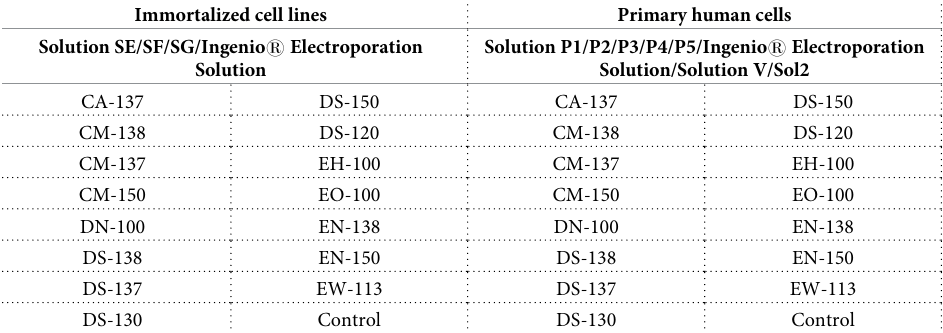
Table 1. CRISPR/Cas RNP delivery to immortalized cell lines and primary human cells using 4D-Nucleofector TM